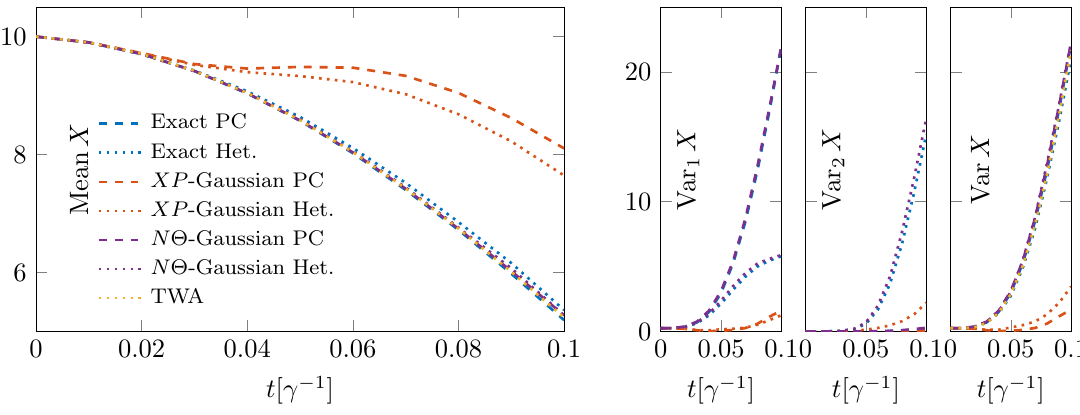
Figure 4. Mean ( left panel) and inner-sample, between-sample and total variances ( right panel) of the X -quadrature obtained by the numerically-exact trajectory methods (in a truncated Fock space) and TWA, as well as XP -Gaussian and N Θ -Gaussian variational methods as a function of time after free = α evolution from a coherent initial state 10 (same parameters as Figure 3). Averages are taken over | (cid:105) | (cid:105) 1e3 samples (1e4 for TWA). It is clear that the N Θ variational method provides an accurate description of the true dynamics, both on the level of the whole ensemble as on the level of its constitution in pure states, whereas the latter cannot be obtained from the TWA method. Very similar behavior is present regarding P and its variances, as well as for the X , P